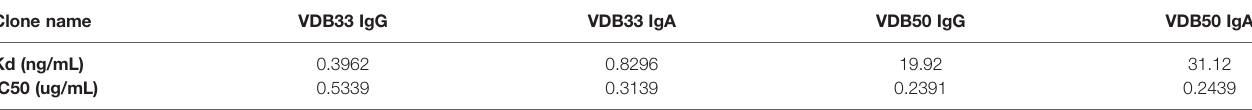
TABLE 2 | Functional characteristics isotype-switched monoclonal antibodies. Clone